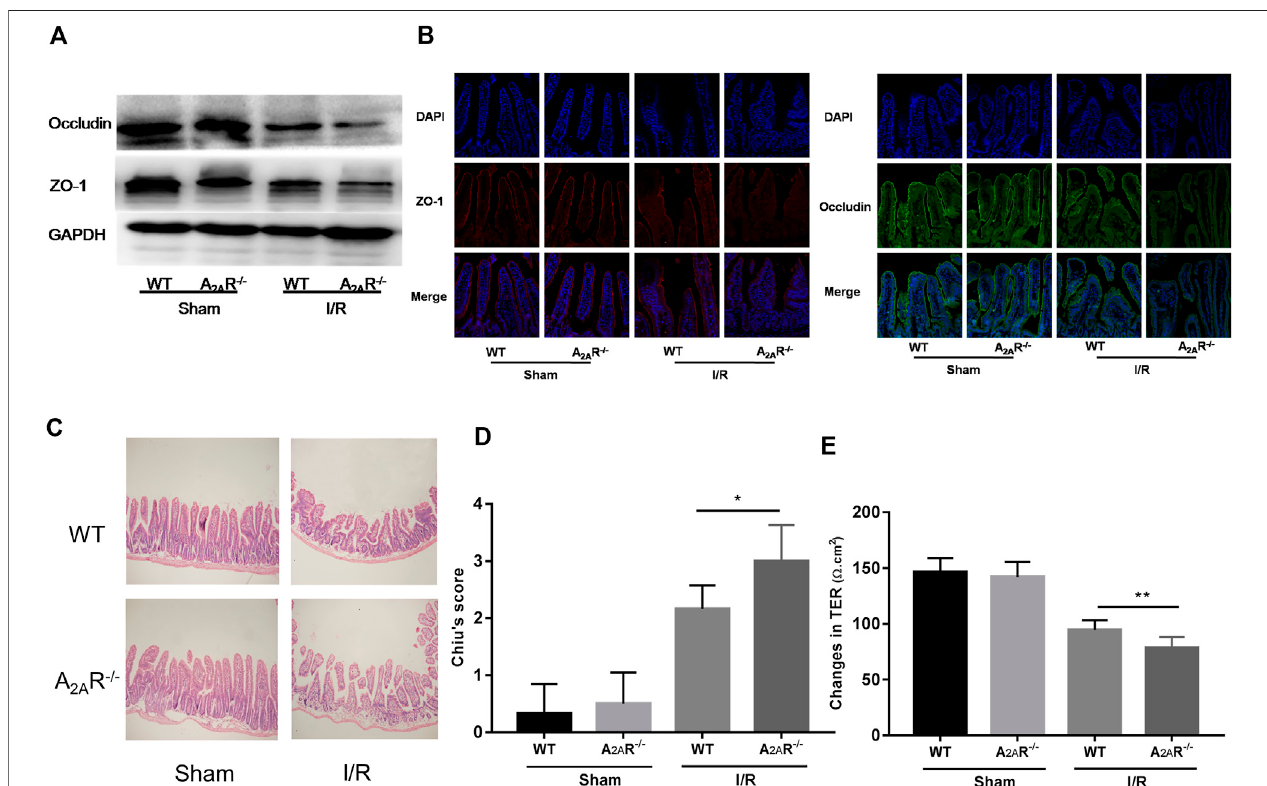
FIGURE3| A 2A Rde fi ciencyaggravatesIR-inducedintestinalepithelialbarrier(IEB)injury.IEBfunctionwasassessed inIR-treatedWTandA 2A R − / − miceby (A) ZO- 1 and occludin protein expression measured by western blot (B) , ZO-1 and occludin protein expression measured by immuno fl uorescence, and (E) the small intestine TER value. The degree of intestinal damage was assessed in IR-treated WT and A 2A R − / − mice by (C) hematoxylin and eosin staining, and (D) Chiu ’ s Score. Results are expressed as mean ± SD ( n (cid:2) 4 – 6 mice/group. * p < 0.05; ** p < 0.01).